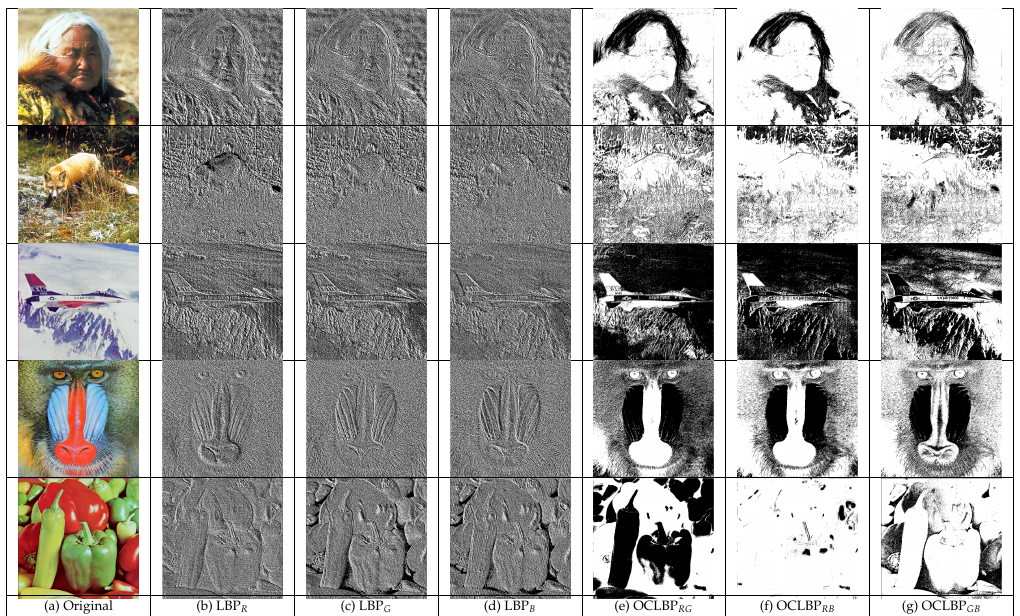
Figure 11. Original images and their output channels, computed using the OCLBP